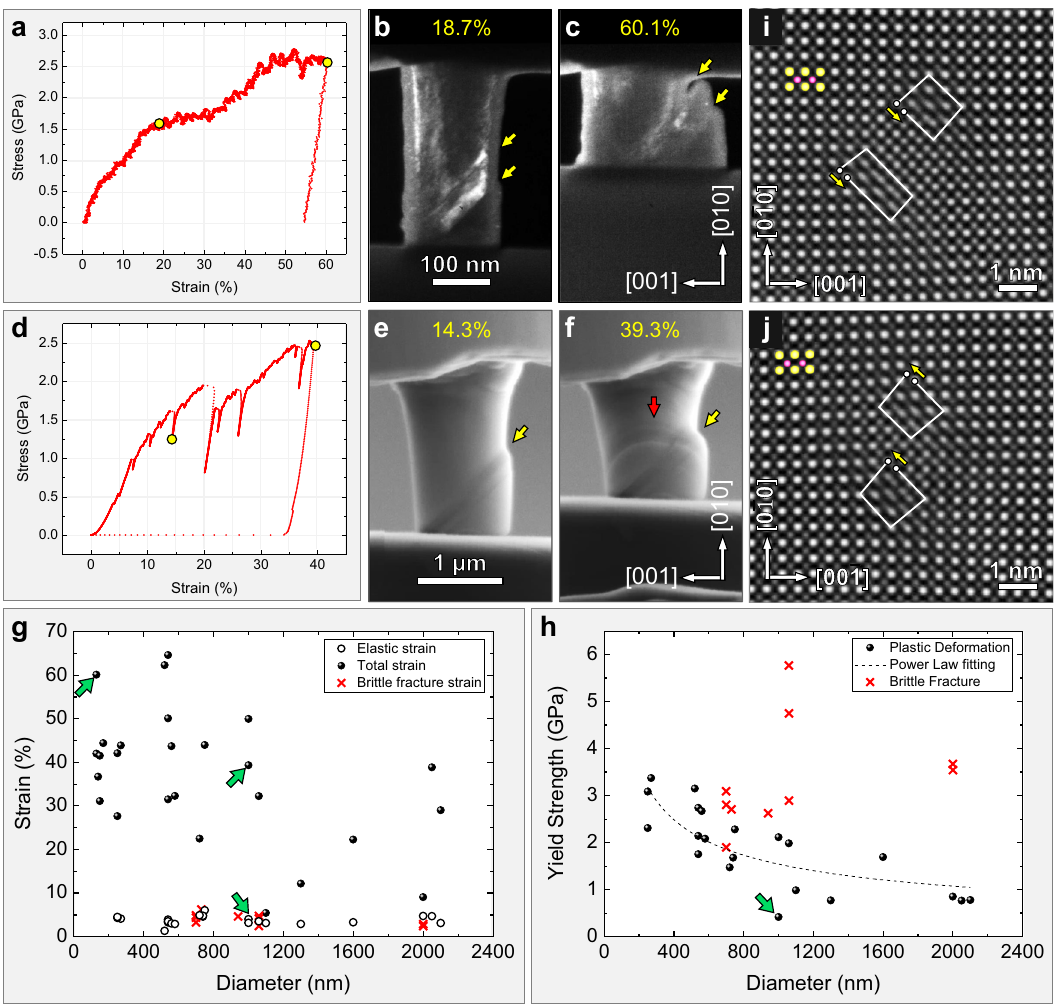
Fig. 1 Compression tests of sub-micro and micrometre scale pillars. a An engineering stress – strain curve acquired during the compression of 140 nm diameter pillar, with a loading direction along [010]. b – c Snapshots from a real-time video recording of a compression test, at strains of 18.7% and 60.1%, respectively (labelled as yellow circles in a ). Slip bands along (011) crystallographic plane and [01 (cid:1) 1] direction is indicated by yellow arrows. Here, both slip plane and slip direction are determined from the change of contrast in TEM images. d An engineering stress – strain curve from a compression test of a 1 µ m pillar. e – f Video snapshots corresponding to strains of 14.3% and 39.3% (yellow circles in d ). Two slip bands (oriented (110)[01 (cid:1) 1] and (1 (cid:1) 10)[110]) are indicated by yellow and red arrows. g Strain as a function of pillar diameter, showing plastic strain (hollow circles) and total strain (spheres) for plastic- deformed pillars and fracture strain (red crosses) for brittle-fracture samples. h Yield strength as a function of pillar diameter, showing yield strength for plastic-deformed pillars (spheres) and brittle-fracture pillars (red crosses). Dashed black curve: fi tted yield strength – diameter curve for plastic-deformed pillars, with a function of y = 56.9 x − 0.52 . Green arrows indicate the strain/stress value corresponding to the pillars shown in Fig. 1 a – c and d – f . i – j STEM- a [011] ( i ) and 1 a [0 (cid:1) 1 (cid:1) 1] ( j ). The partial dislocations are separated by stacking HAADF images showing pairs of partial dislocations with Burgers vectors of 1 2 2